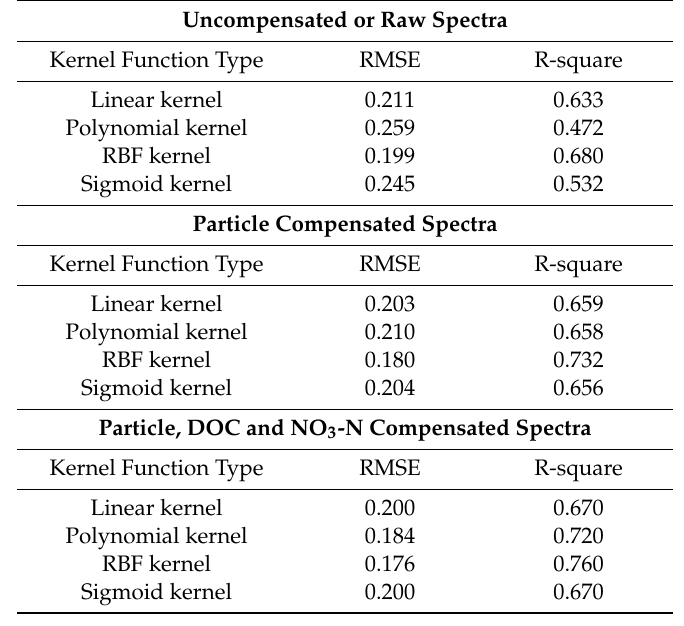
Table A3. SVR modelling performance in terms of RMSE and R-square for di ff erent kernel functions in